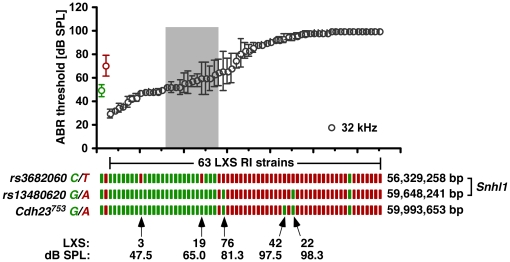

Snhl1 phenotype/genotype correlation.ABR thresholds at the 32 kHz stimulus of each of the 63 RI strains (grey) and the parental ILS (green) and ISS (red) strains as a function of their genotype at markers rs3682060, rs13480620, and Cdh23753 are shown. ABR thresholds (in dB SPL; Y-axis) are given as mean ± SD (n = 4). The grey box denotes the number of strains and threshold range unexplained by Snhl1. The ISS allele is shown in green (C, cytosine; G, guanine) and the ILS allele is represented in red (T, thymidine; A, adenine) boxes. The number of the RI strain carrying a recombinant chromosome and the threshold at the 32 kHz is shown below the haplotypes. On the right, the physical location of the marker on chromosome 10 in base pairs (bp) is given and the most likely location of Snhl1 is indicated.